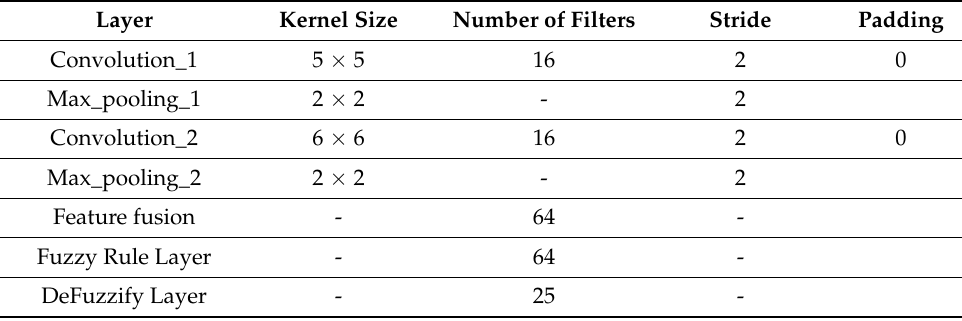
Table 9. Optimal parameter combination for the FT-CFNN.